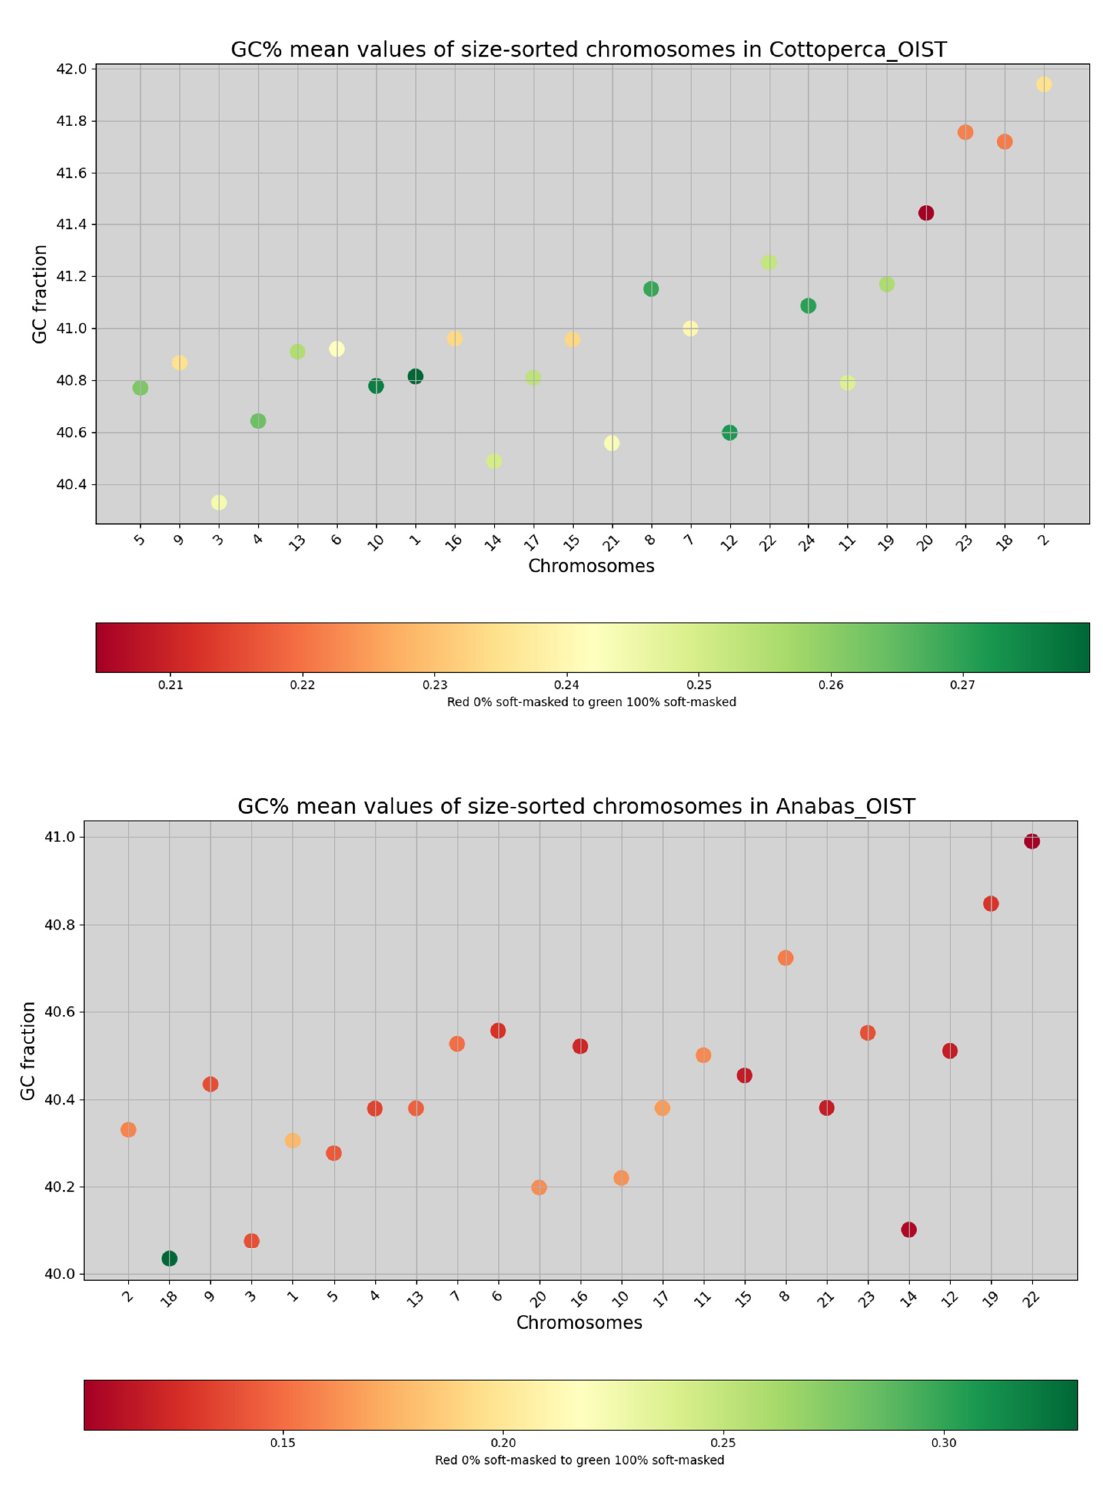
Figure 2. Overview of the two genome assemblies analysed in this study. Each chromosome ( x -axis) is represented as a dot, with the y -axis showing GC% values. Chromosomes are sorted by size, from largest to smallest. The colour gradients of the dots reflect the proportion of soft-masked sequences (rep%) with the two extremes being red, indicating unmasked, and green, indicating soft-masked regions. The colour scale below each graph represents a species-specific flexible range of the soft- masking percentage. The sliding window size is 1000 nt for both species. A putative sex chromosome (no. 18) in A. testudineus is shown demonstrating a high proportion of repeats for its